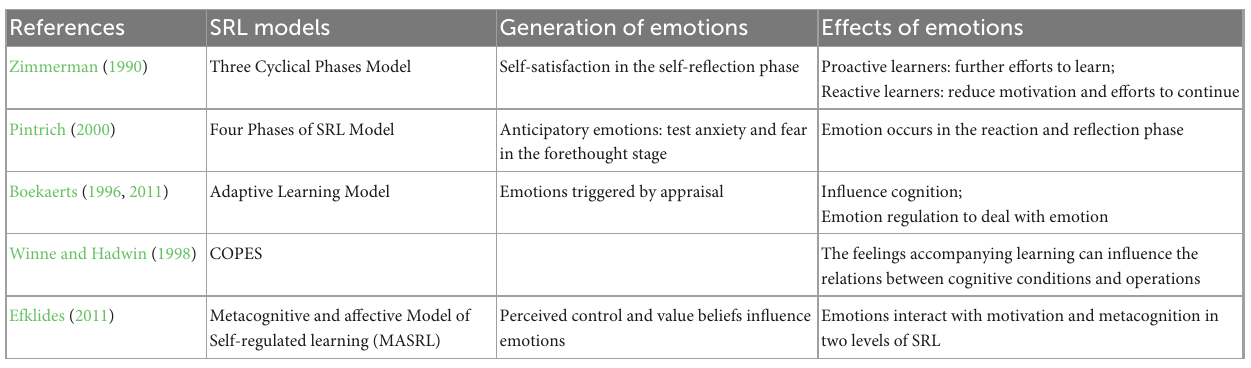
TABLE 1 The role of emotions in self-regulated learning (SRL)